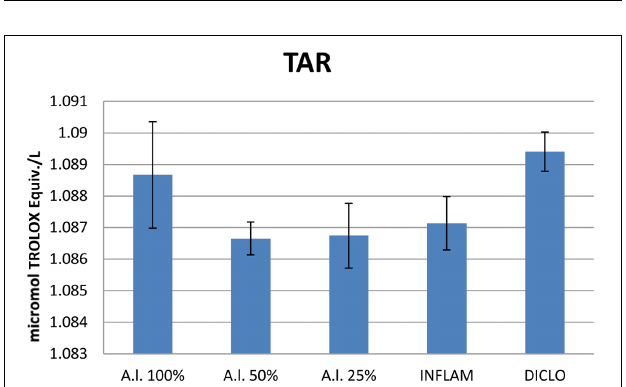
FIGURE 10 | NO synthesis. A.l. 100% – the animals received 5 mL/kg BW A. laxmannii ethanol extract 100% (100 mg dw/mL), A.l. 50% – the